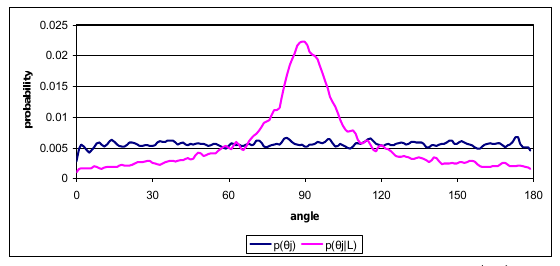
Figure 2: Pixel gradient direction probability density and the edge pixel gradient direction probability density